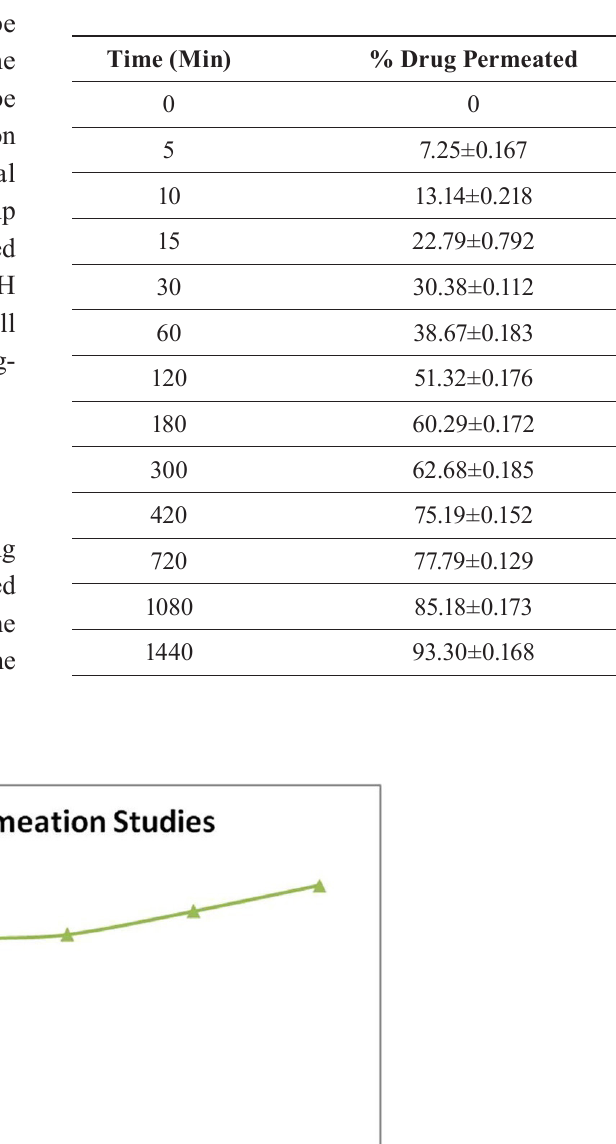
TABLE IV: - Skin Permeation studies for final ethosomal gel